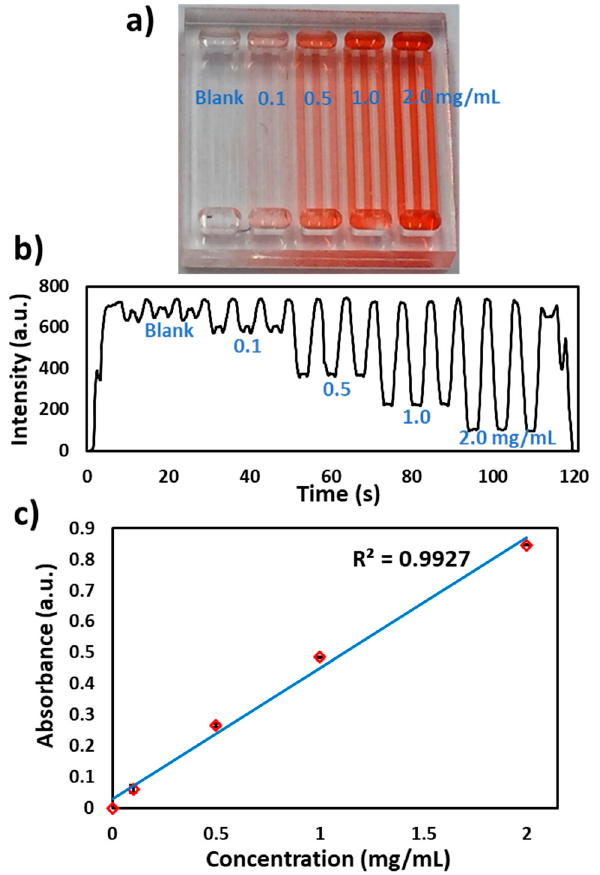
Figure 4. Characterization of the flow cell. ( a ) Photograph of different concentrations of red food dye in microchannels (blank, 0.1, 0.5, 1.0 and 2.0 mg/mL). ( b ) Transmitted light intensity profile of the microchip with different food dye concentrations. ( c ) Absorbance calibration of the detector response for different food dye concentrations. The absorbance of the food dye increases linearly with increase in dye concentration.